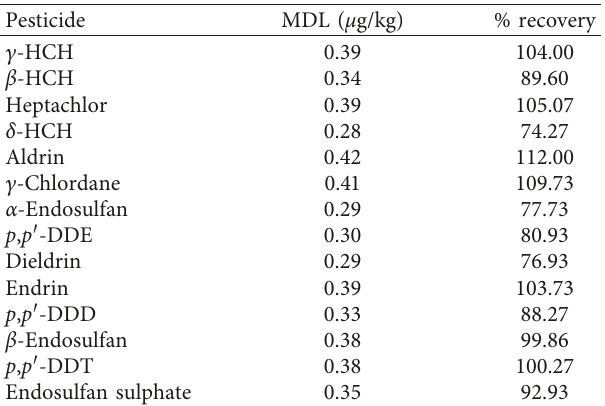
Table 1: Recoveries and method detection limits (MDLs) for the analysis of the 15